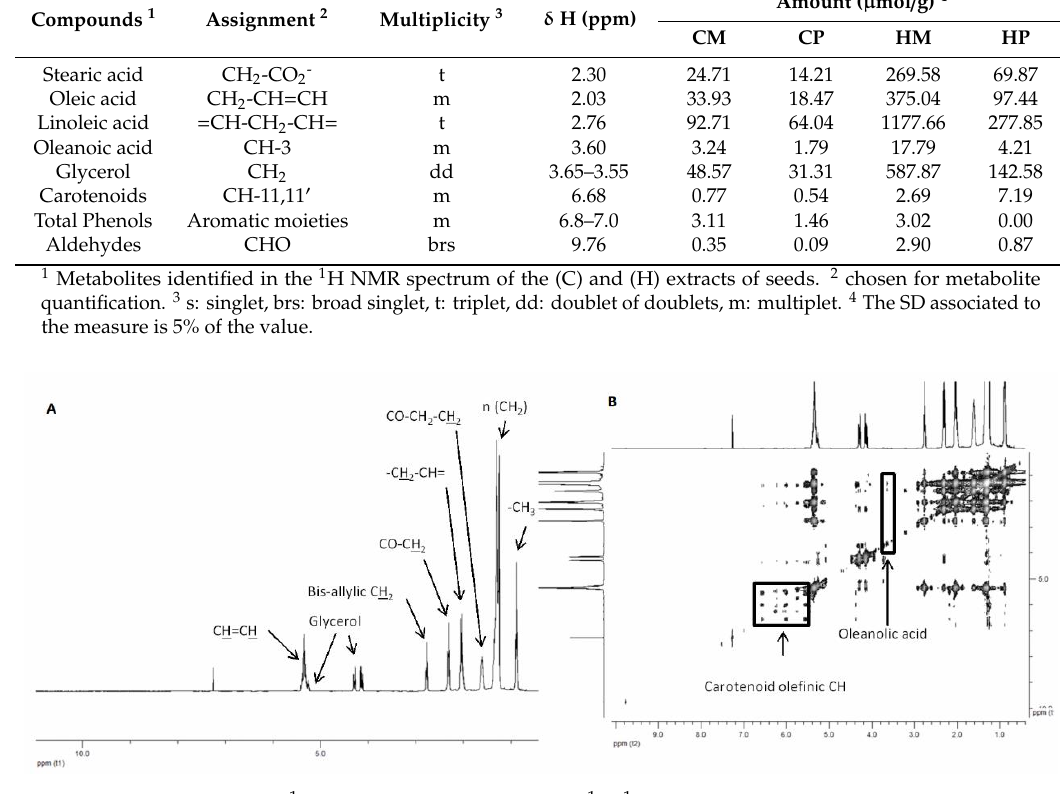
Figure 1. Representative 1 H monodimensional ( A ) and 1 H- 1 H TOCSY ( B ) NMR spectra of HP extract.